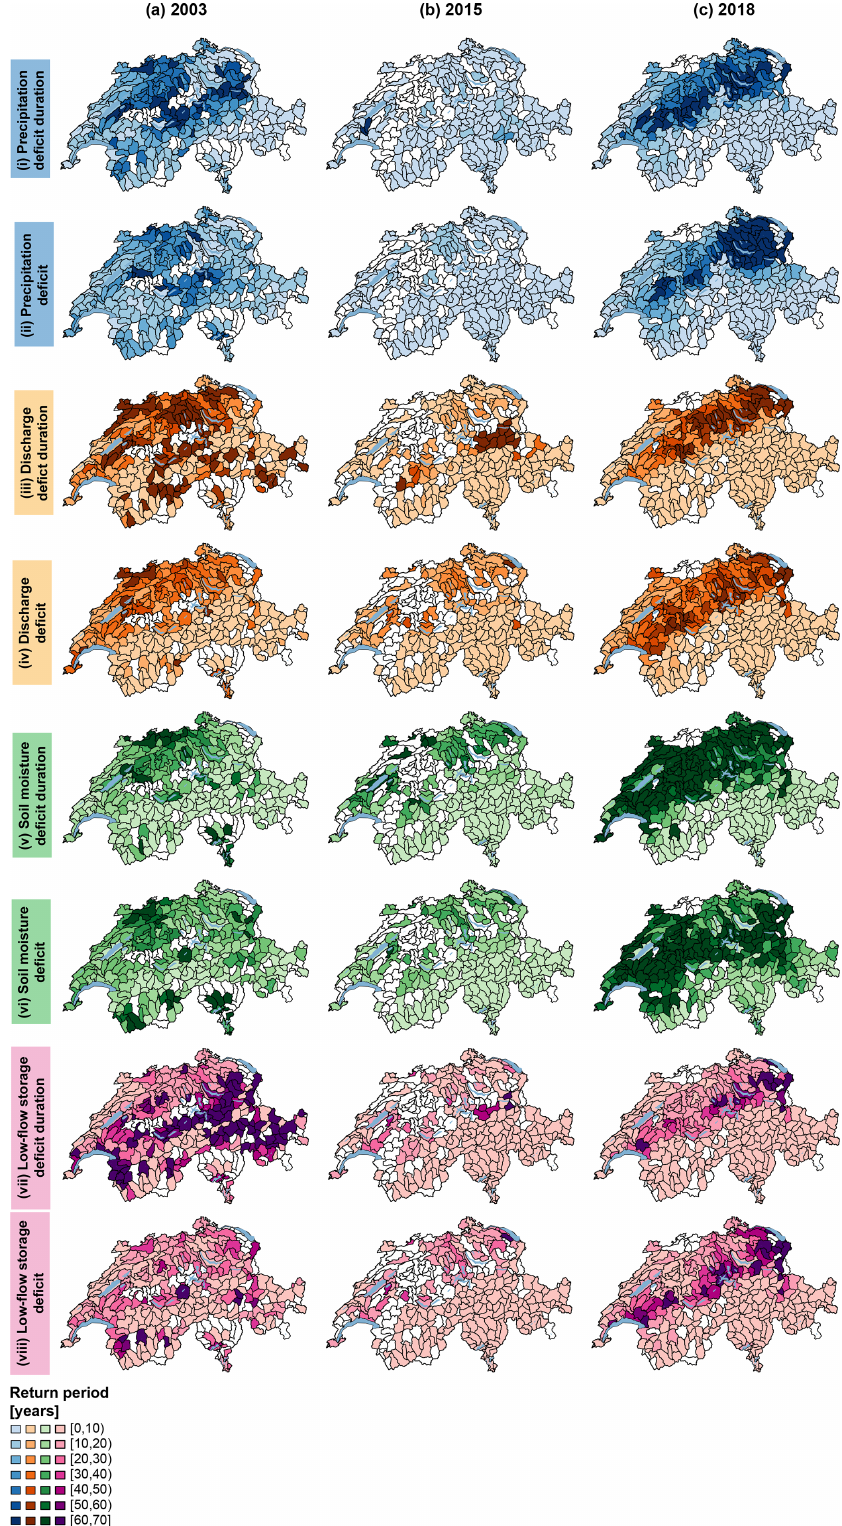
Figure 8. Univariate return periods estimated for the drought events in (a) 2003, (b) 2015, and (c) 2018 for the 307 catchments in the simulated dataset for the eight variables (i) precipitation deficit duration, (ii) precipitation deficit, (iii) discharge deficit duration, (iv) discharge deficit, (v) soil moisture deficit duration, (vi) soil moisture deficit, (vii) low-flow storage deficit duration, and (viii) low-flow storage deficit. For catchments displayed in white, no joint event for all variables was